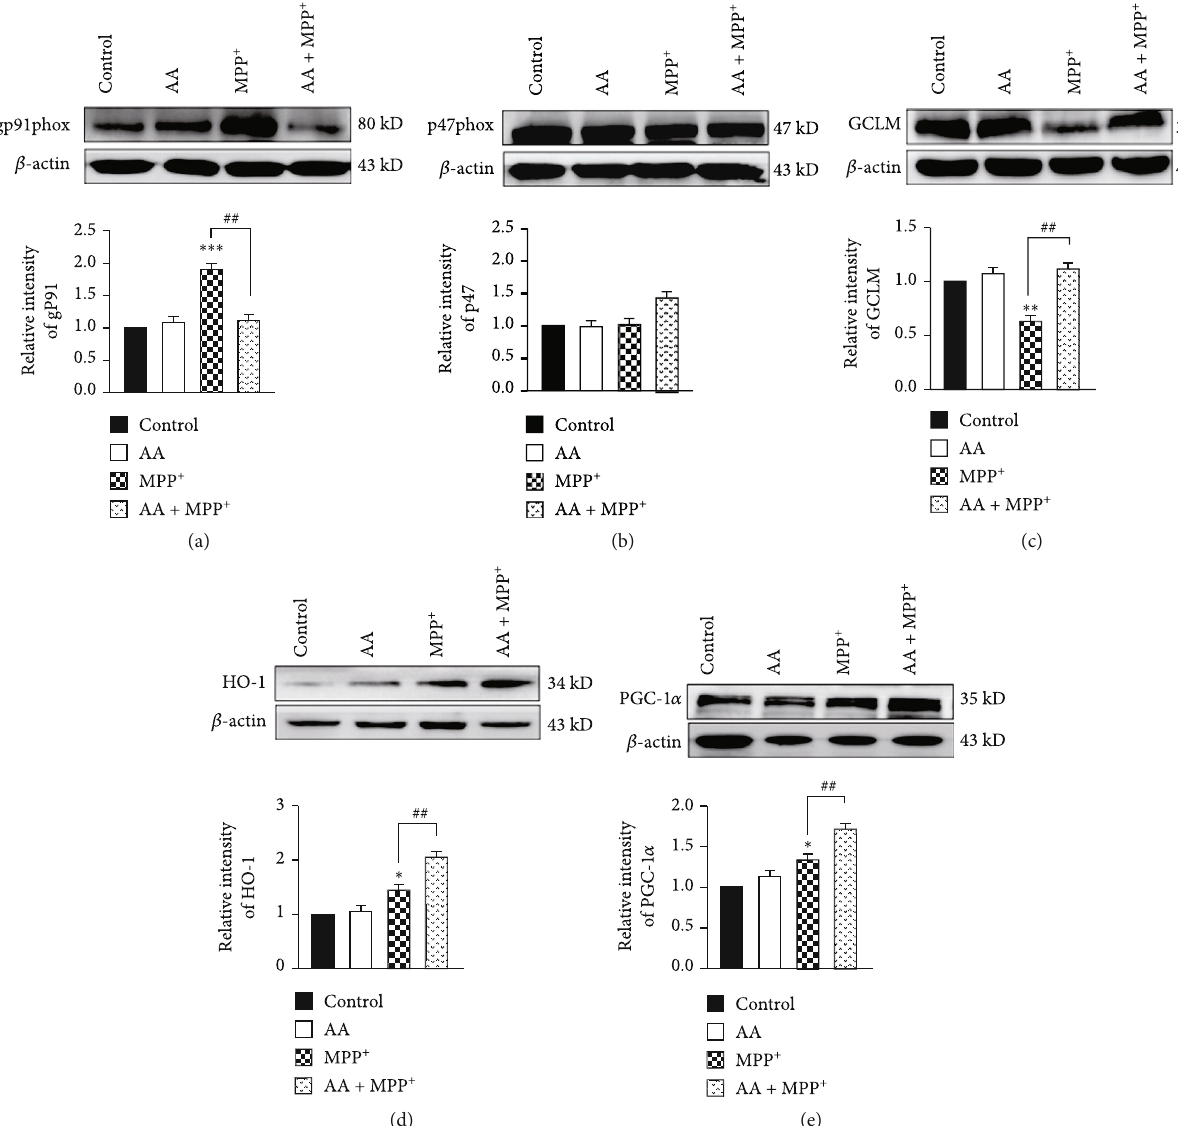
Figure 2: Ascorbic acid inhibits MPP + -induced nicotinamide adenine dinucleotide phosphate (NADPH) oxidase activation and enhances the expression of antioxidative proteins in astrocytes in vitro . Primary astrocytes were treated with 1mM of AA for 24 h and/or 1 mM of MPP + for another 24 h. (a) The expression of total gp91phox was detected by Western blotting ( n = 3 ). (b) The expression of total p47phox was detected by Western blotting ( n = 3 ). (c) The expression of GCLM was detected by Western blotting ( n = 3 ). (d) The expression of HO-1 was detected by Western blotting ( n = 3 ). (e) The expression of PGC-1 α was detected by Western blotting ( n = 3 ). Data were obtained from three independent experiments. One-way ANOVAs followed by LSD pairwise comparisons were performed. ∗ was considered signi fi cant compared to control ( ∗ P < 0 : 05 , ∗∗ P < 0 : 01 , and ∗∗∗ P < 0 : 001 ). # was considered signi fi cant compared to MPTP or MPP + ( # P < 0 : 05 , ## P < 0 : 01 , and ### P < 0 : 001 e ff ects in MPP + -treated astrocytes in vitro through NF- κ B signaling.